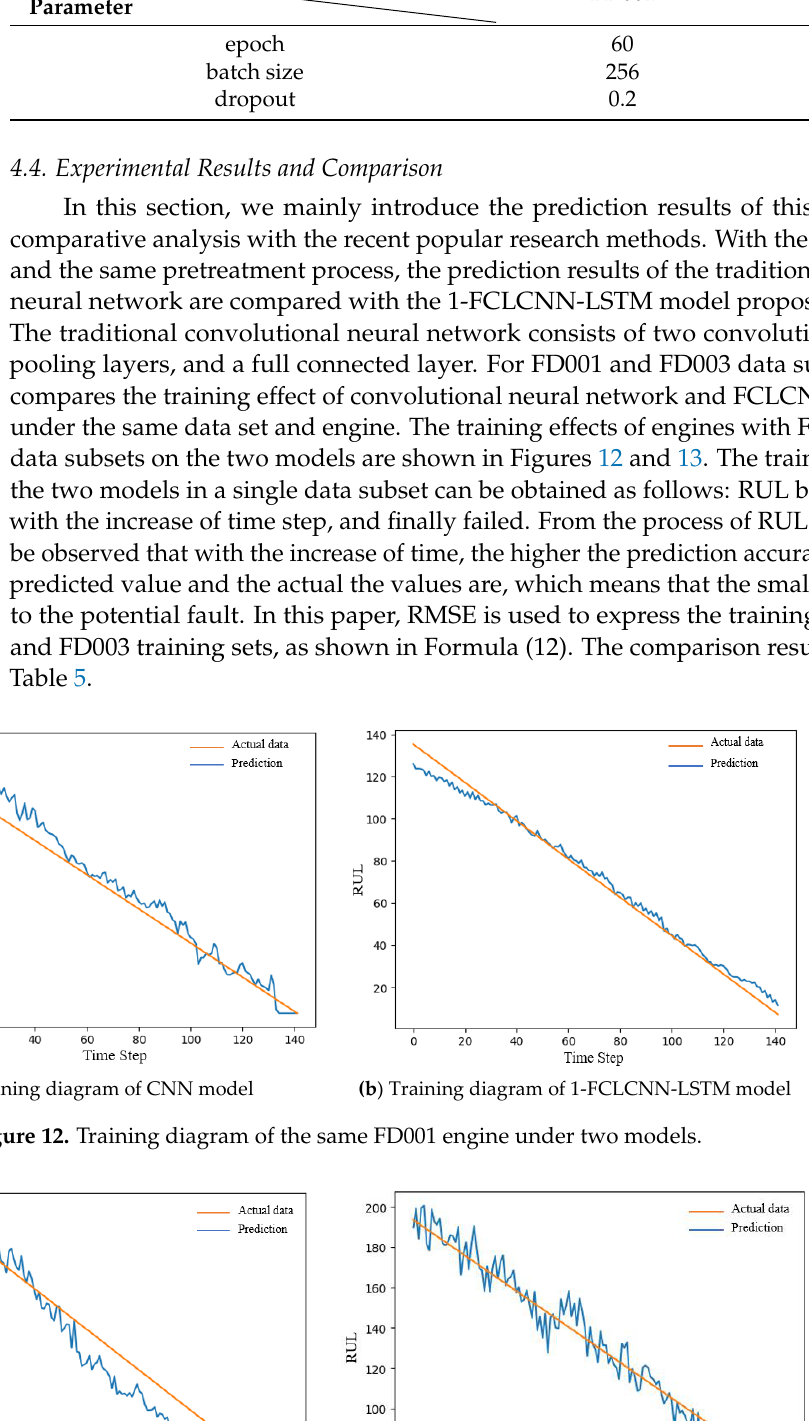
Table 4. Model parameter Settings for FD001 and FD003 data subsets.